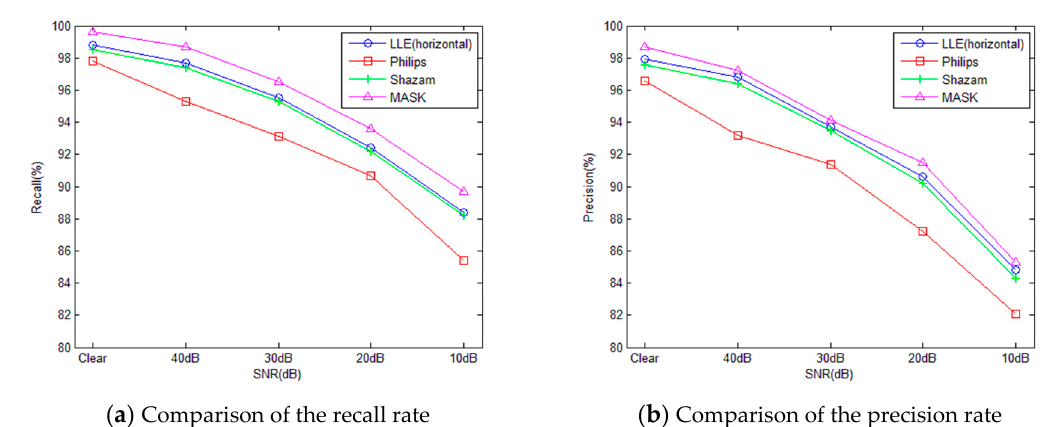
Figure 8. Comparison of horizontal reduction with other methods.